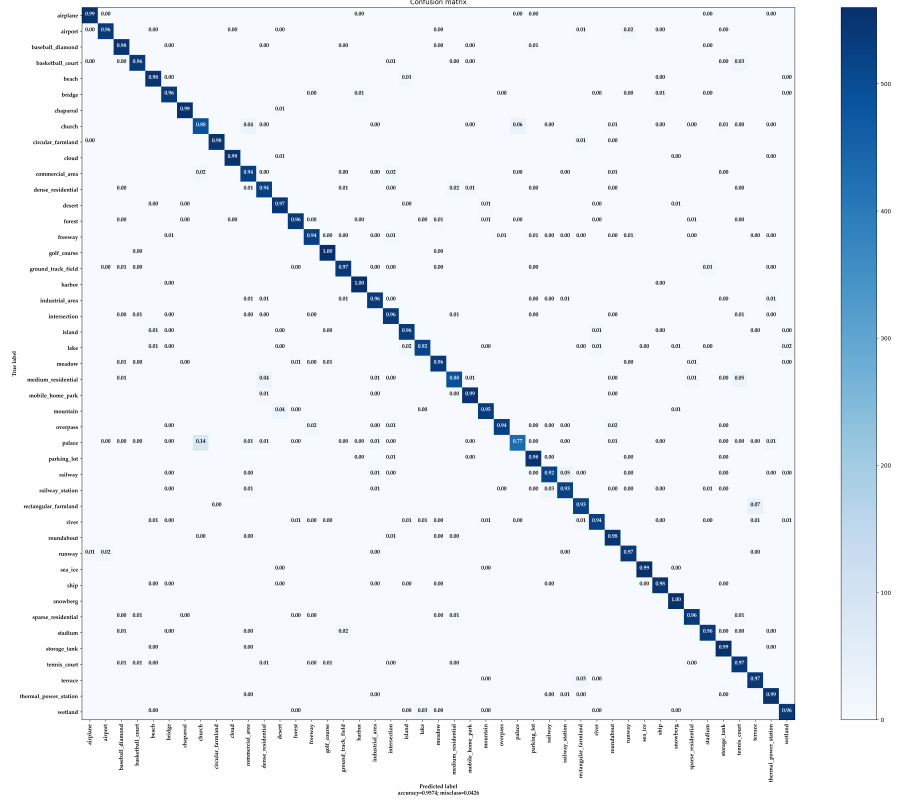
Figure 10. Confusion matrix of our P 2 FEViT (ViT-B/ResNet50) on NWPU-R45 (train:test =